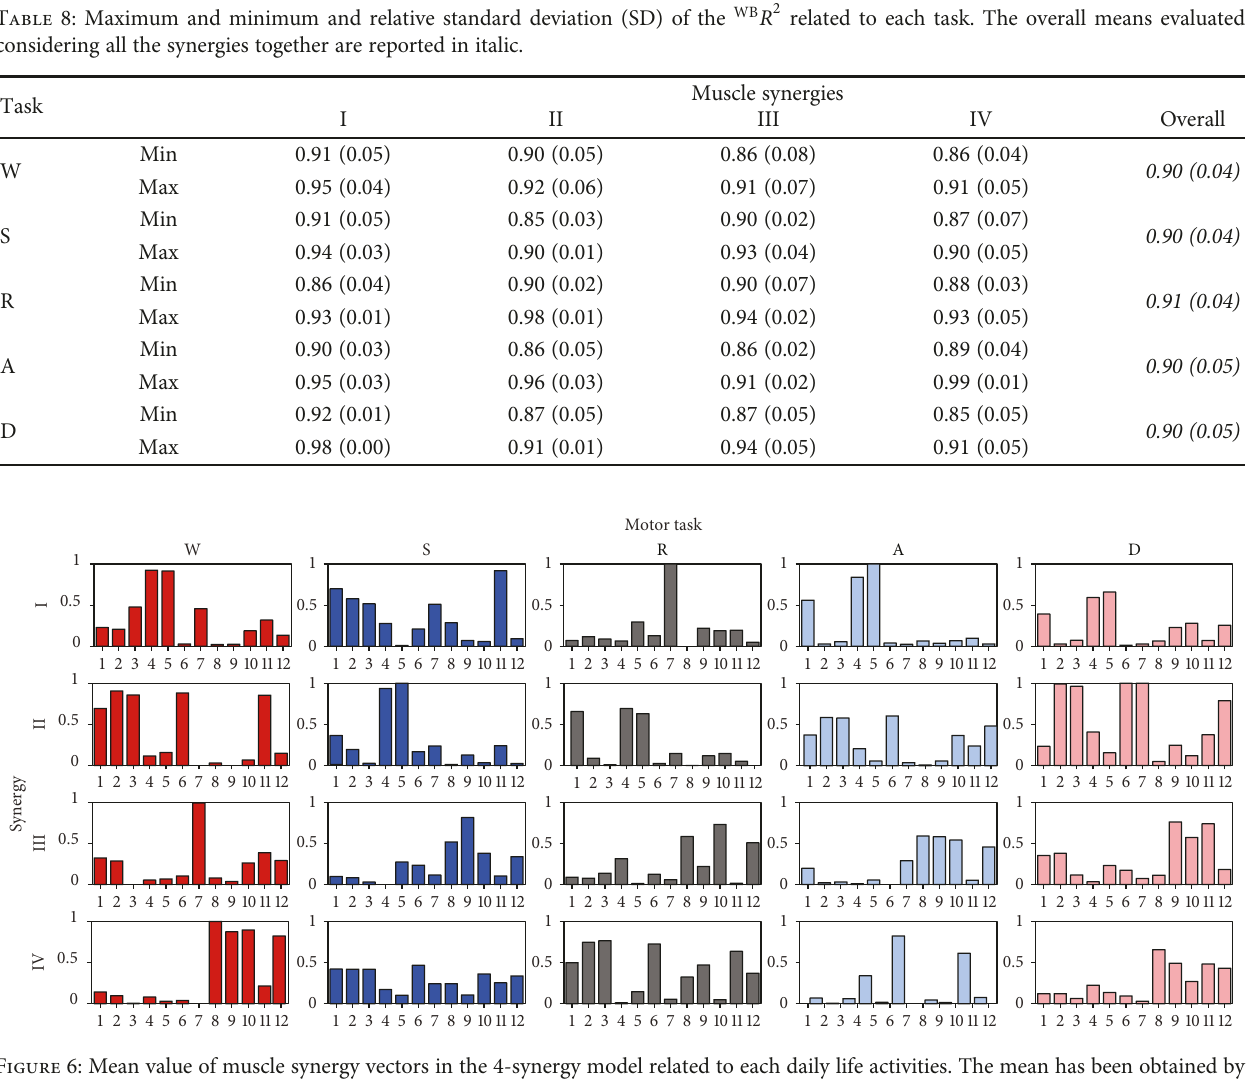
related to each task. The overall means evaluated sim